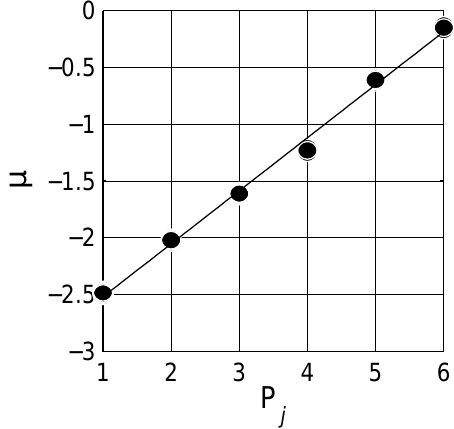
Figure 12 . Peak positions, µ = log( x ) . The solid line is a linear fit with µ = 0 . 470 P where j is the peak number in Table 1.